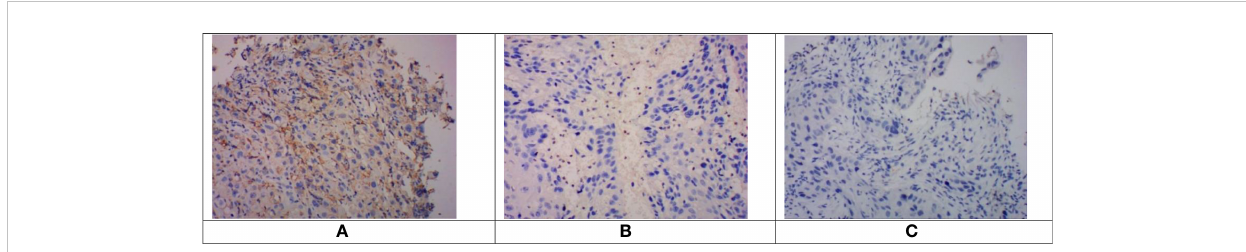
FIGURE 1 Immunohistochemical staining of PD-L1 in esophageal squamous cell carcinoma tissues. Images were obtained from three different patients. (A) . CPS > 10. (B) 1 < CPS 5 < 10. (C) CPS < 1 (negative of PD-L1 expression). PD-L1, programmed cell death protein ligand 1; CPS, combined positive